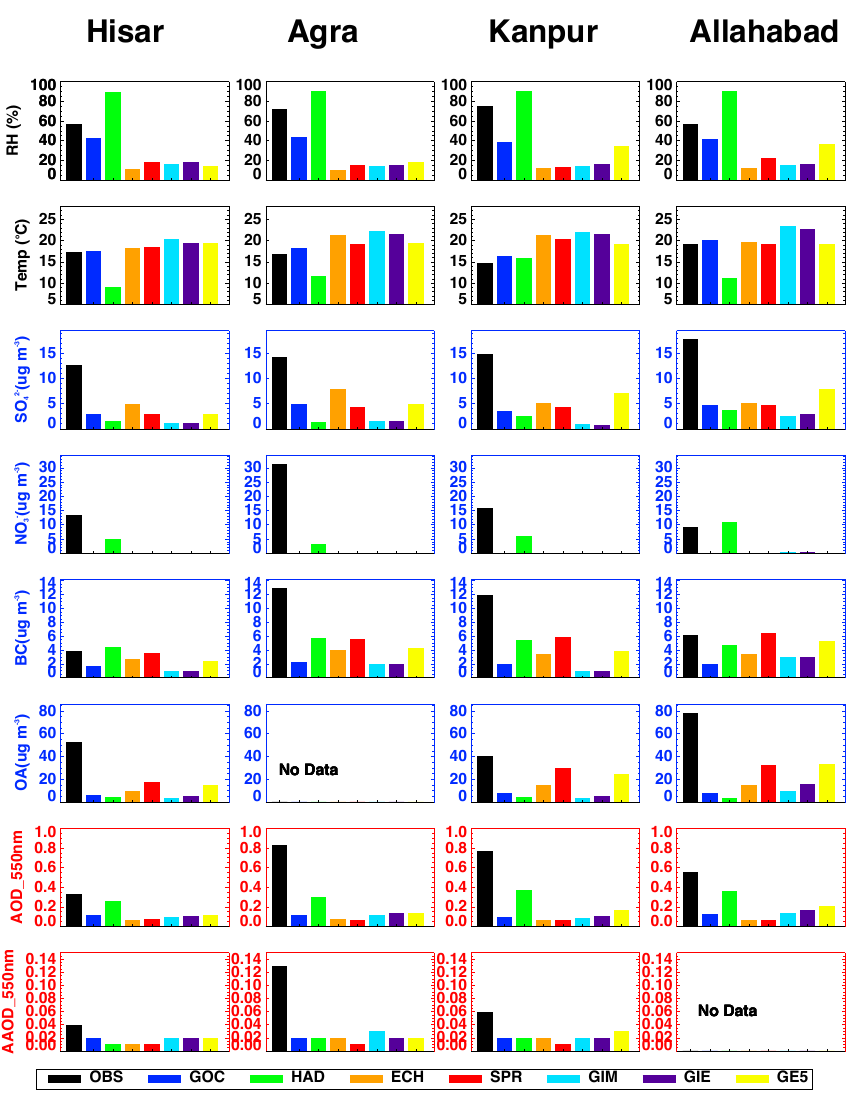
Figure 10. Comparisons of seven models against ISRO-GBP campaign measurements at four IGP stations (Hisar, Agra, Kanpur, Allahabad from western to eastern IGP) in December 2004. The variables include meteorological fields of surface relative humidity (RH) (1st row) and surface temperature (2nd row), aerosol species mass concentrations of SO 2 − and columnar AOD (7th row) and AAOD (8th row) at